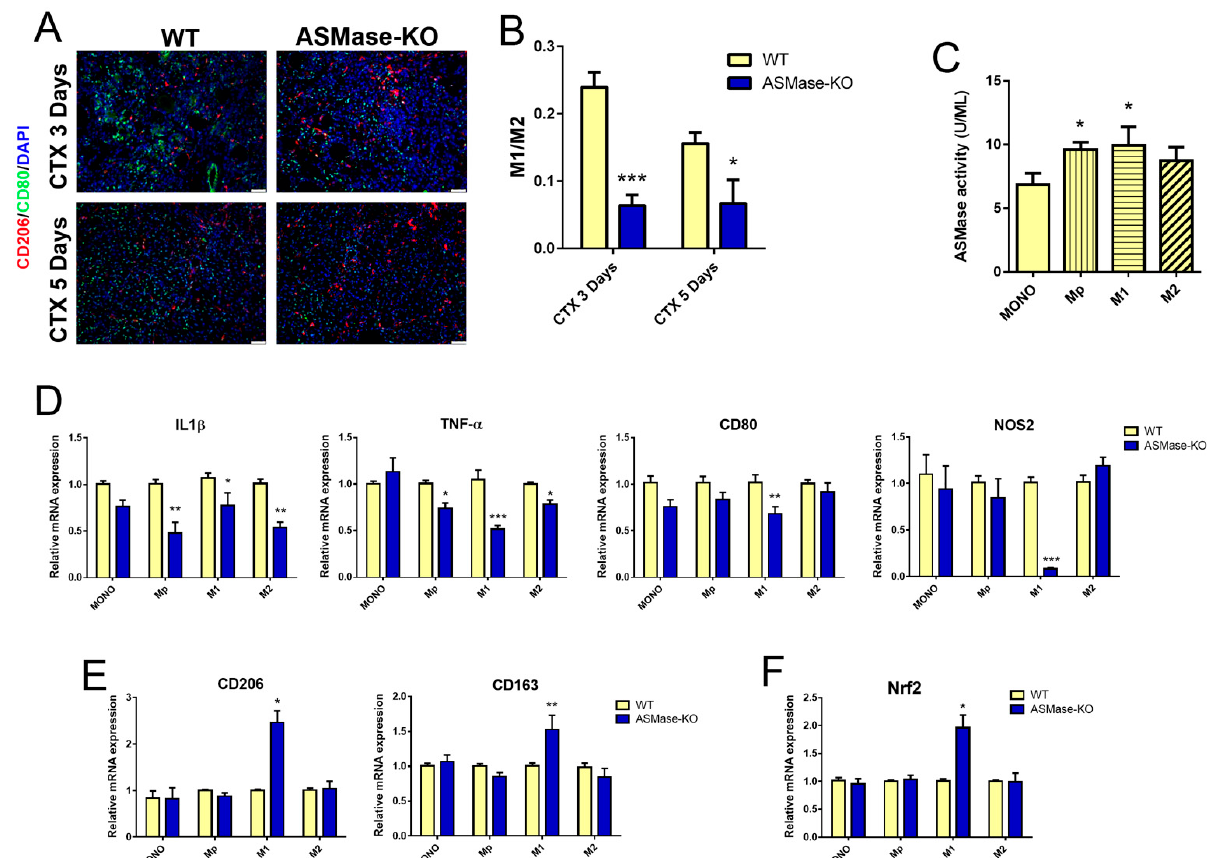
Figure 5. ASMase in macrophage differentiation and polarization. ( A ) Representative images of CD206 (red) and CD80 green immunostaining and DAPI nuclear counterstaining (blue) of transverse sections from WT and ASMase-KO TA muscles at 3 and 5 days after CTX injection. ( B ) M1/M2 ratio quantification by flow cytometry in TA muscles at 3 and 5 days after CTX injection in WT and ASMase-KO mice ( n ≥ 3 mice for each group). Values are expressed as mean ± SEM normalized vs. the untreated controls (dashed line). * p < 0.05, *** p < 0.001 vs. the respective WT. ( C ) ASMase activity measured at different stages of macrophages differentiation and polarization, i.e., monocites (MONO), differentiated macrophages (Mp), M1-polarized macrophages (M1) and M2-polarized macrophages (M2) from WT mice. Values are expressed as mean ± SEM ( n ≥ 3 mice). * p < 0.05 vs. MONO. ( D – F ) RT-qPCR analysis of the M1 markers IL1 β , TNF- α , CD80 and NOS2 ( D ), the M2 markers CD206, and CD163 ( E ) and Nrf2 ( F ) in MONO, Mp, M1 and M2 from WT and ASMase-KO mice. Values are expressed as mean ± SEM ( n ≥ 3 mice) normalized vs the untreated control. p < 0.05, ** p < 0.01, *** p < 0.001 vs. the respective WT.